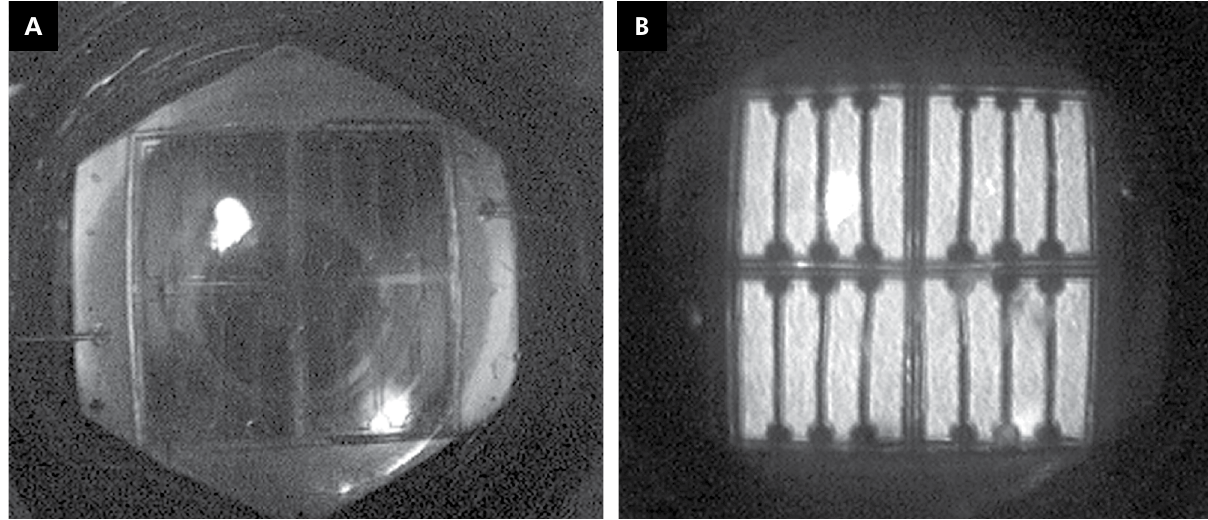
Figure 26. Second generation blue LED chip array, shown in the powered-off (A) and powered-on (B) modes.